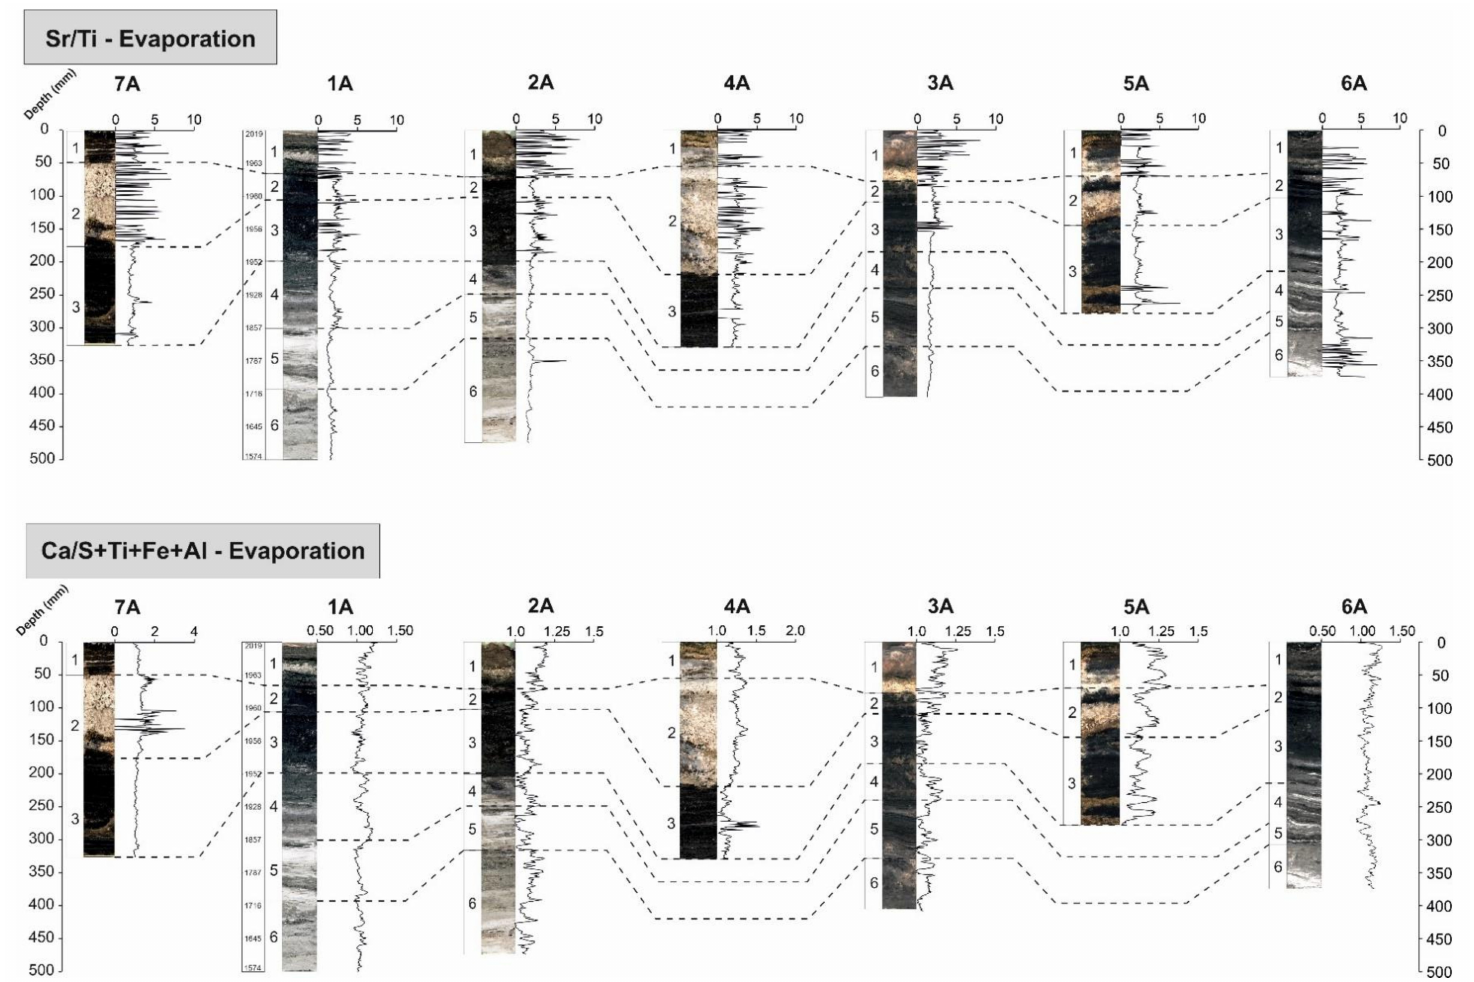
Figure 9. Figure illustrating spatio-temporal variations in geochemical proxies typically used for determination of the intensity of evaporation [21]. Increasing values indicate increasing evaporation for both